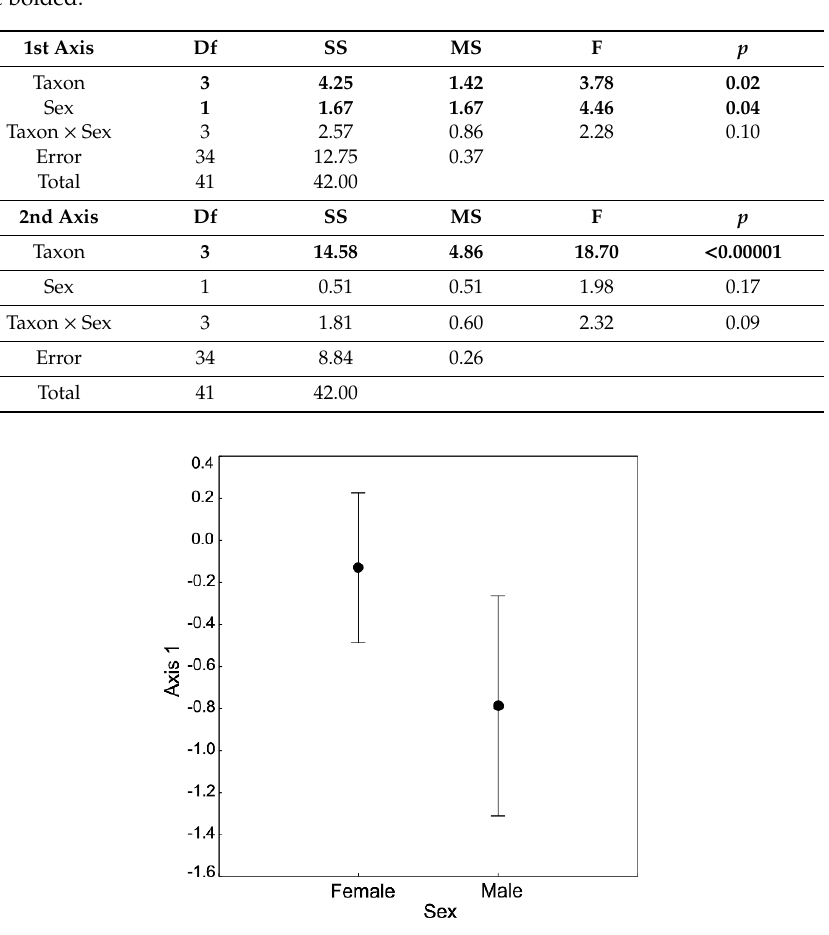
Table 2. Two-way ANOVA performed separately for 1st and 2nd axis scores. Statistically significant results are bolded.